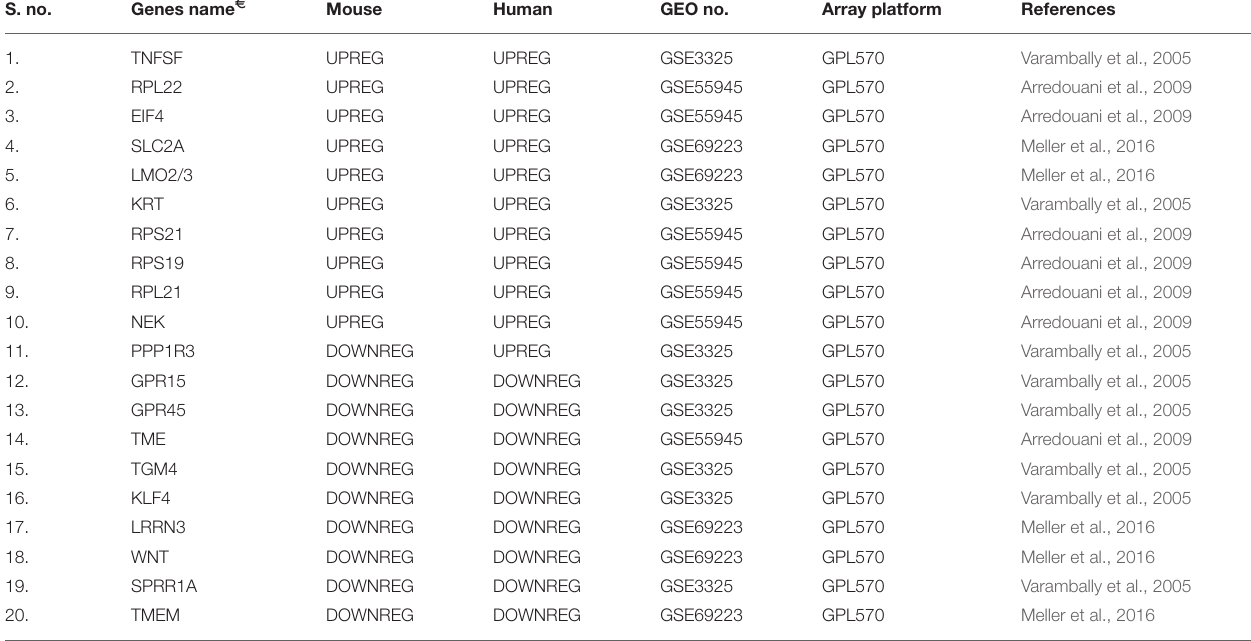
e A list of 20 genes were identified by overlaying three human prostate cancer vs. benign prostate microarray studies with our TRAMP microarray. Ten of 10 genes were confirmed as upregulated whereas nine of 10 genes were downregulated in TRAMP tumors.